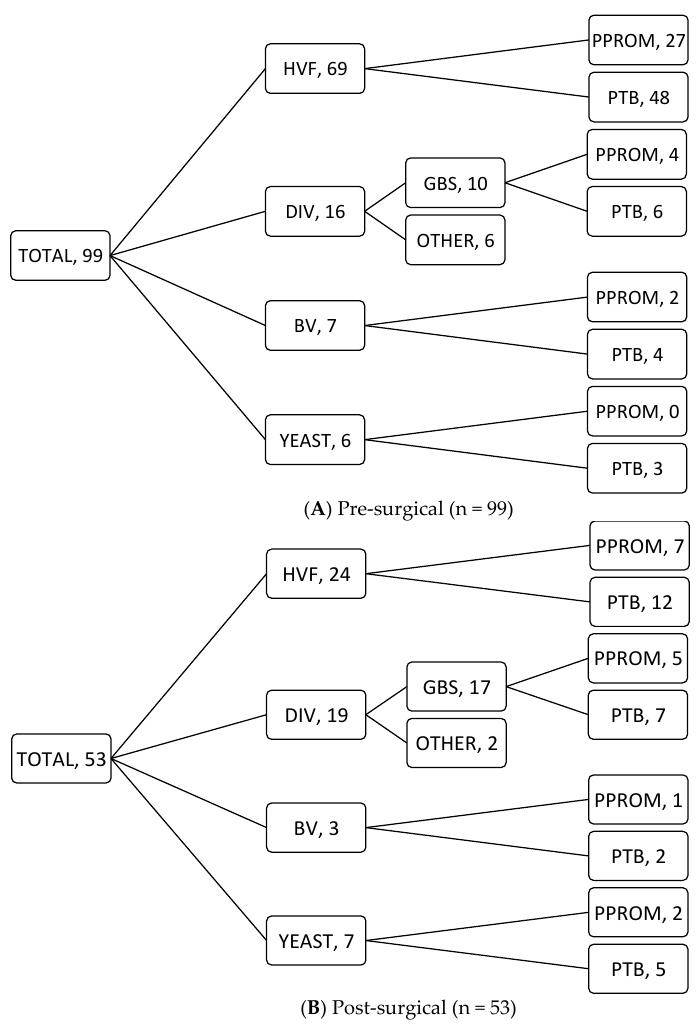
Figure 2. Results of vaginal swabs pre-surgical ( A ) and post-surgical ( B ) and their relation with PPROM and PTB; HVF–healthy vaginal flora, DIV–desquamative inflammatory vaginitis, BV–bacterial vaginosis.